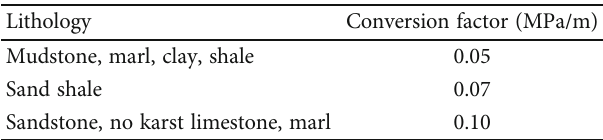
Table 4: Conversion coe ffi cient of test compressive strength for each